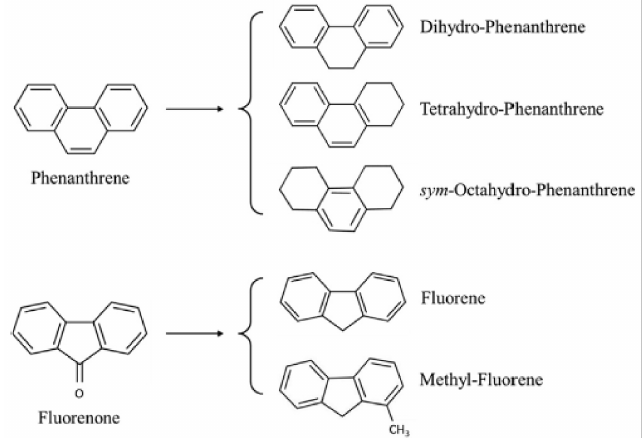
Figure 11. Reaction products of the chemical markers added to the system